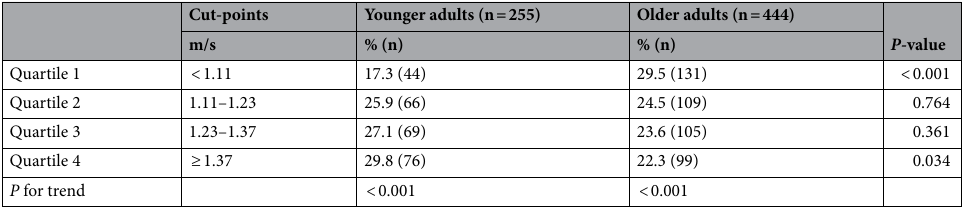
Table 2. The distribution of younger adults and older adults in the overall daily gait speed quartiles. Equality of proportions was analysed. Each age in the four groups was compared using Cochran-Armitage trend tests.